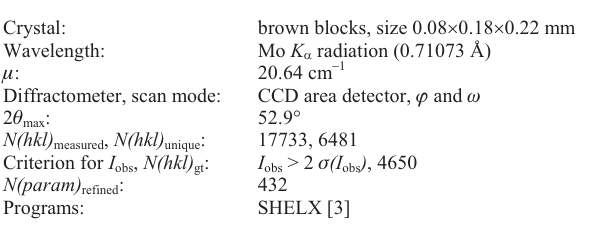
Table 1. Data collection and handling.